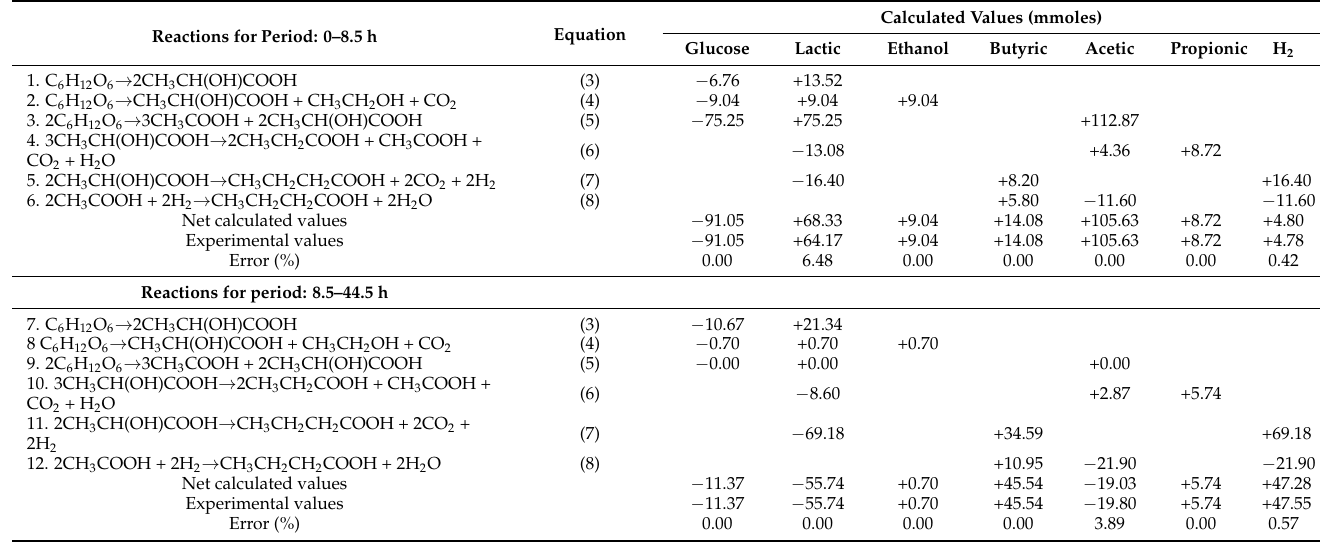
Table 3. Mass balances for hydrogen production at the optimum pH